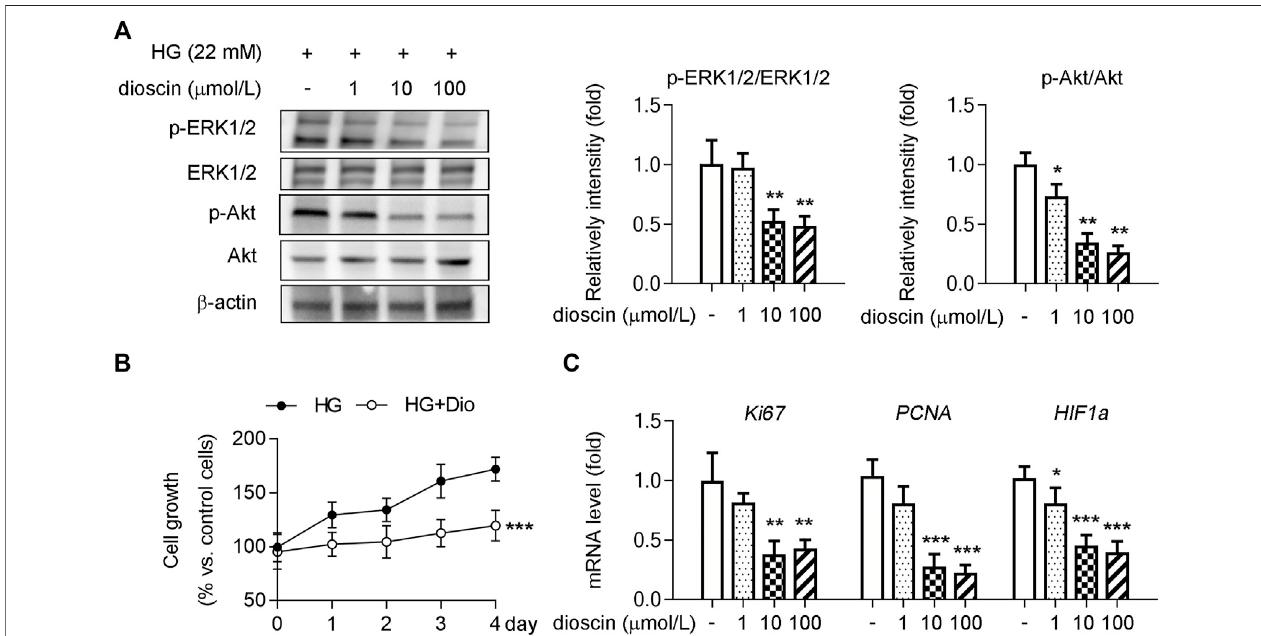
FIGURE2| DioscininhibitsHRMECproliferationinanHGenvironment.HRMECstreatedwithdioscinasindicatedinpanelA. (A) Proteinlevelsofp-ERK1/2,ERK1/ 2,p-Akt,andAktweredetectedbyWesternblot,andthequantitativeresultsareshownintherightpanel, n (cid:1) 3. (B) CellgrowthofHRMECswasassessedusingaCCK-8 assay, n (cid:1) 3. (C) MRNA levels of Ki67, PCNA , and HIF1 α were determined by qPCR, n (cid:1) 5. * p < 0.05, ** p < 0.01, and *** p < 0.001 vs. the control group by one-way ANOVA with Bonferroni correction.